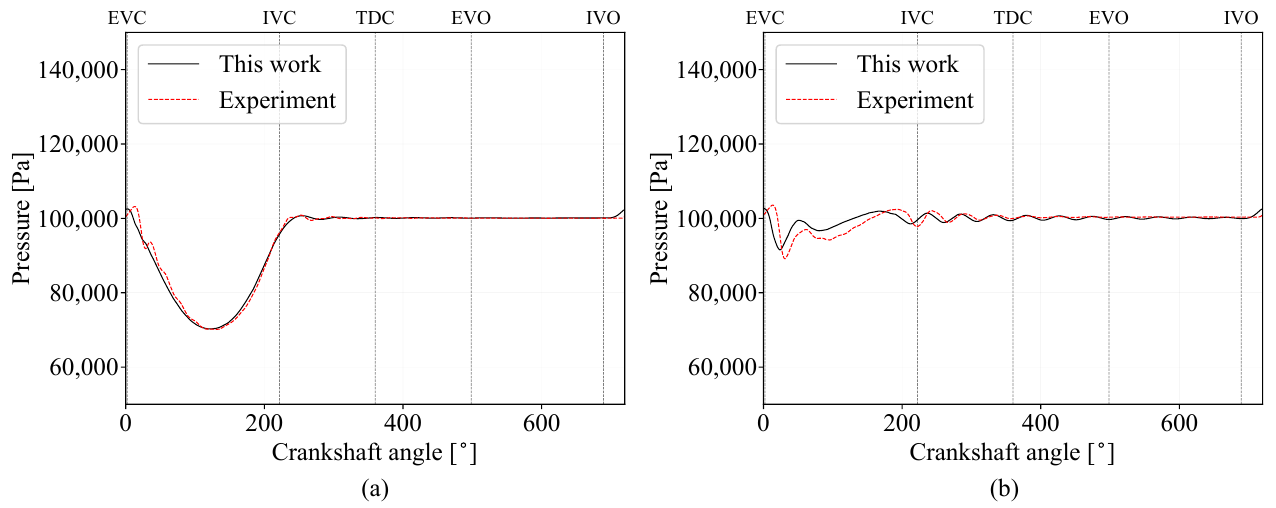
Figure 14. Experimental and numerical intake runner pressure as a function of engine crank angle for both throttle valve positions: ( a ) throttle at 35 ◦ ; ( b ) throttle at 80 ◦